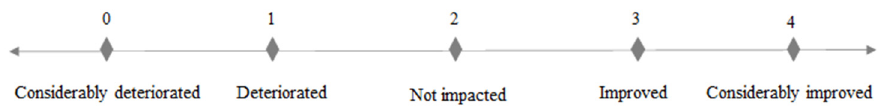
Figure 1. Integrated scale for impact on sleep quality and mood.